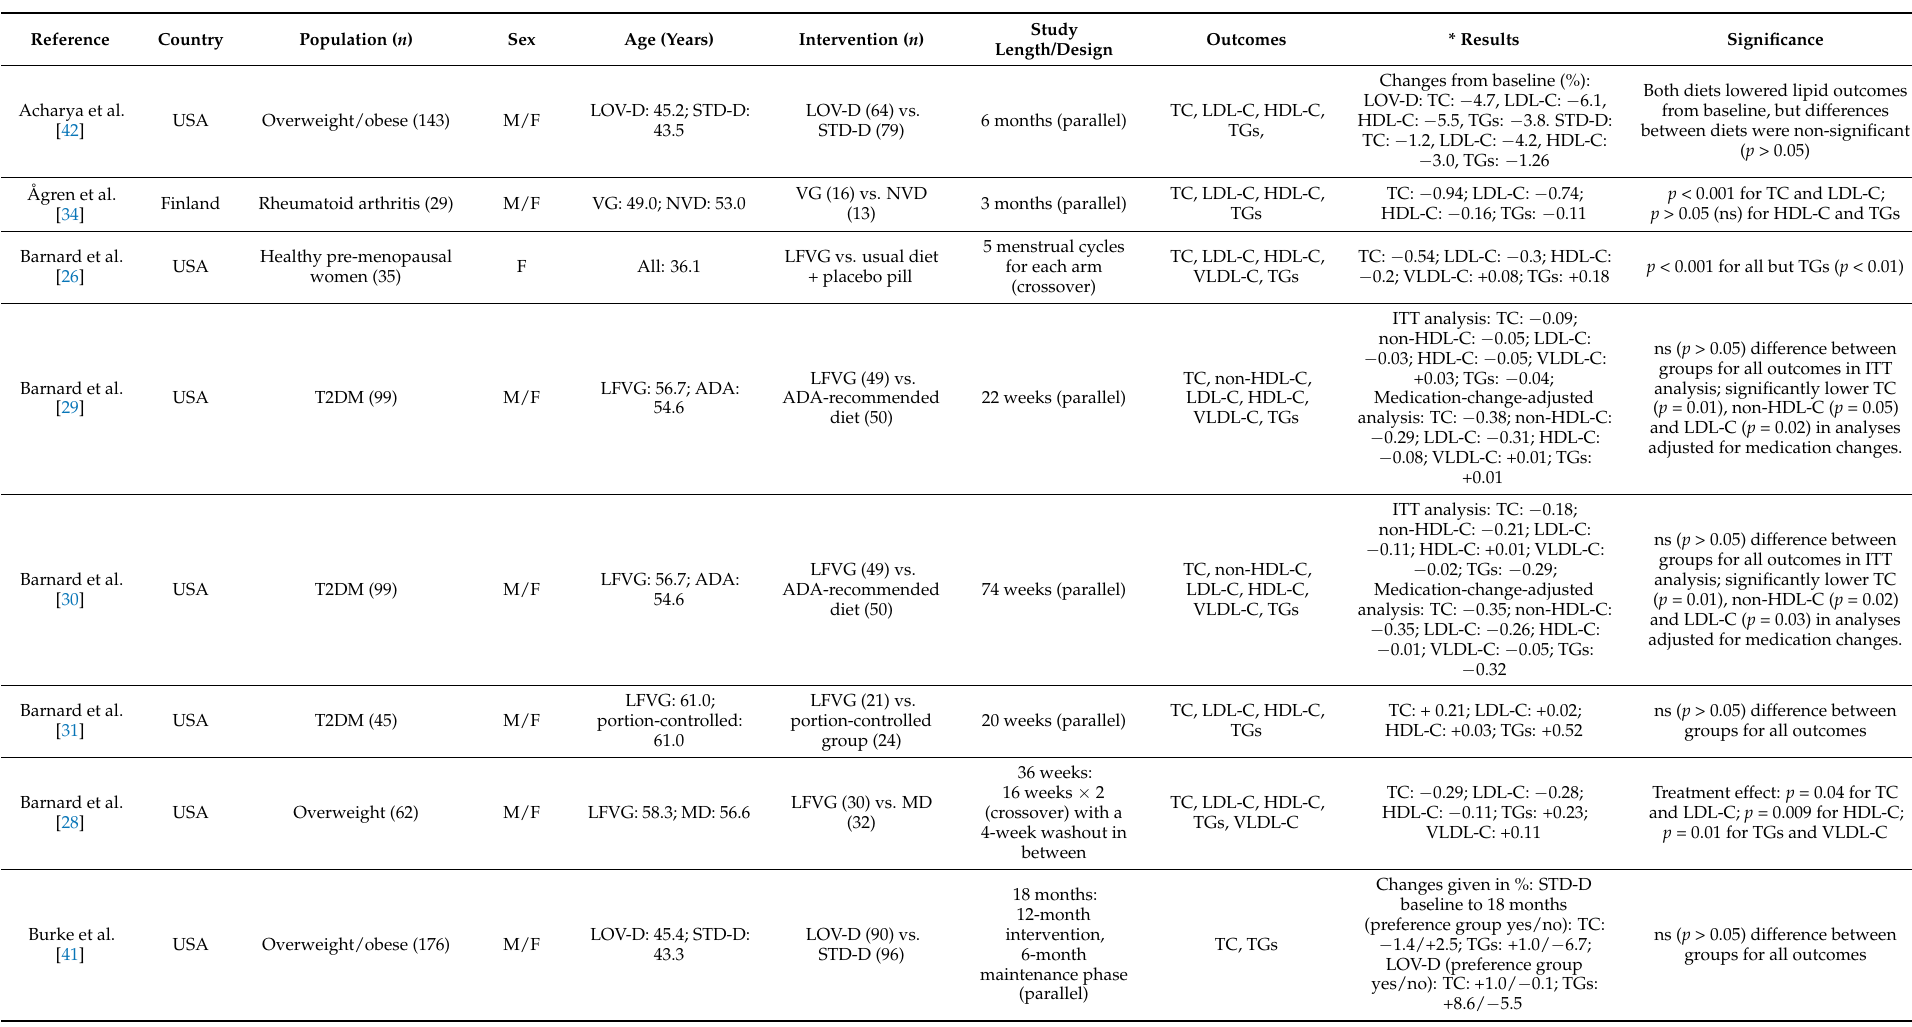
Table 3. Randomised Controlled Trials of Plant-Based Diets and Lipid